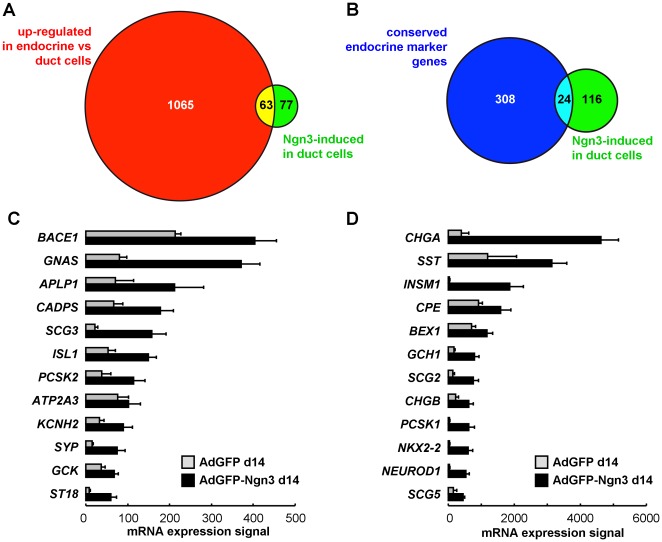
Extent of Ngn3-mediated duct-to-islet endocrine reprogramming.Transcripts that are ≥1.5-fold (LB) higher expressed in untransduced human endocrine versus suspension cultured duct cells (n = 1128 on the HG133A array, panel A, green) were compared to the 140 transcripts that were AdGFP-Ngn3-activated as compared to AdGFP-transduced duct cells using the same statistical criteria (panel A and B, gray). Nearly half (45%, 63 of 140) of Ngn3-regulated transcripts (panel A, intersect) are expressed in endocrine cells. Panel B compares these 140 Ngn3-activated transcripts (gray) to a previously reported [16] panel of 332 genes with beta cell-selective expression in mouse, rat and human. Ngn3 activated 24 of these endocrine marker genes. Gene chip mRNA expression signal (mean±SD, n = 3) in transduced duct cells is shown in panels C and D.